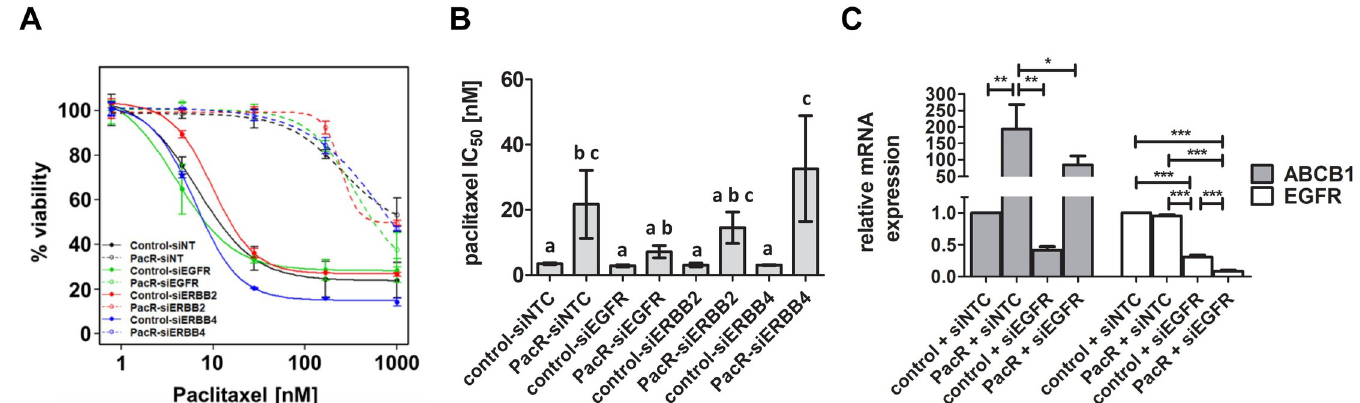
Fig 4. Differential regulation of ABCB1 expression by EGFR in ovarian cancer cell lines. (A) Dose response curves following siRNA knockdown of EGFR, ERBB2 or ERBB4 in TOV-21G-control and–PacR cells indicating cell viability after 96 hours of exposure to paclitaxel. (B) Paclitaxel IC50 in OVCAR3-control and -PacR cells following knock-down of EGFR, ERBB2, and ERBB4 expression. Bar plots depict average IC50 +/- standard error of the mean (SEM). ANOVA p < 0.0001. Bars not sharing subscripts are significantly different (Tukey’s p < 0.05). (C) ABCB1 and EGFR expression measured with real-time PCR 72 hours after siEGFR transfection in OVCAR3 cells. Relative expression was compared using one-way ANOVA (ABCB1 p = 0.001; EGFR p < 0.0001) and Tukey’s Multiple Comparison Tests ( � p < 0.05, �� p < 0.01, ��� p < 0.001).